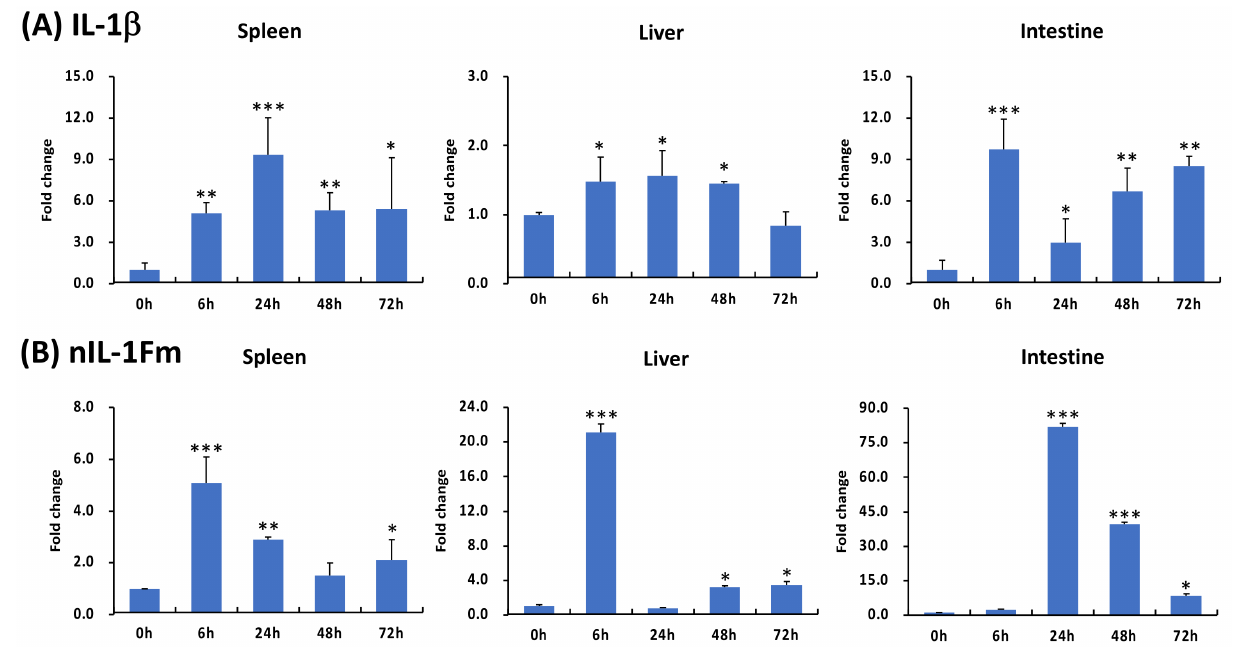
Figure 9. Comparative expression of IL-1 ( A ) and nIL-1F ( B ) in the liver, gut, and spleen of bacterial- infected with S. agalactiae in Nile tilapia. Samples from four fish were collected at 6, 24, 48, and 72 h post bacterial infection. The fold change in comparison to the control was presented as the expression levels were normalized by β -actin (which was set to 1). The results are presented as mean + SEM. One-way analysis of variance (ANOVA) was used to compare the gene expression levels (* p < 0.05, ** p < 0.01, *** p <